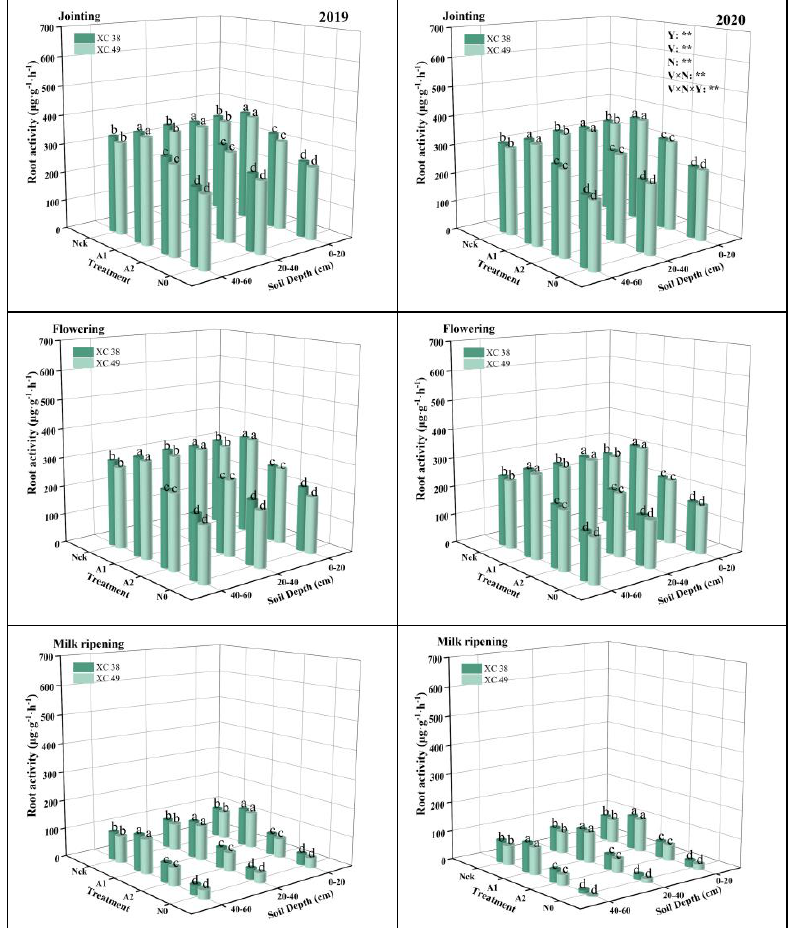
Figure 1. Effect of nitrogen supply on root activity of drip-irrigated spring wheat. Note: XC 38: Xinchun 38; XC 49: Xinchun 49. Nck: 300 kg·ha −1 ; N0: 0 kg·ha −1 ; A1: 240 kg·ha −1 ; A2: 210 kg·ha −1 . V: variety, N: different nitrogen treatments, and Y: year. “**” indicates significant difference at 0.01 levels, ns indicates insignificant difference. Different lowercase letters indicate significant differences between treatments at the 0.05 level.